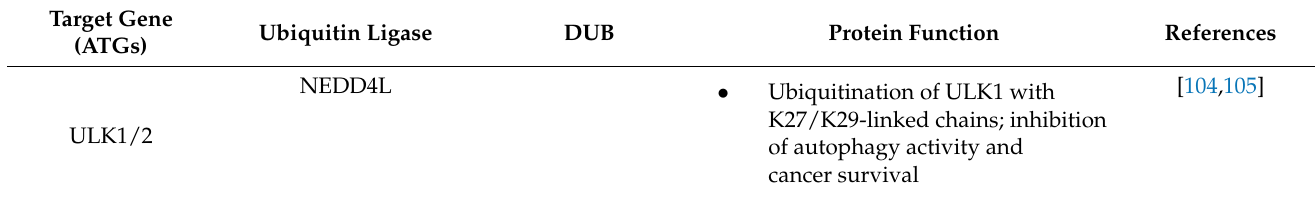
Table 2. Ubiquitin ligases and deubiquitinating enzymes that regulate ATG